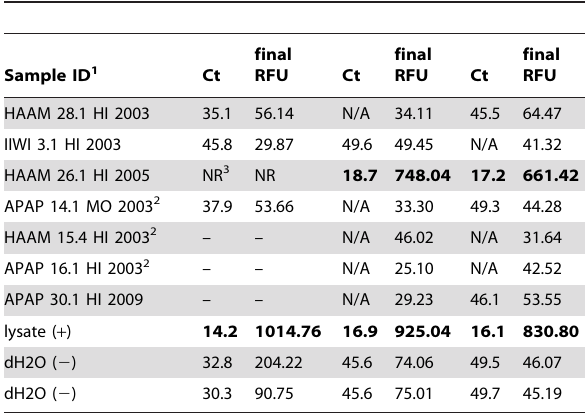
Successful amplifications (Ct , 25 and final RFU . 425) are indicated in bold . All values are based on PCR Base Line Subtracted Curve Fit Data as calculated using iCycler version 3.1 software (BioRad). The threshold intensity was 37.0 rfu for the first reaction, 48.3 rfu for the second reaction, and 10.8 rfu for the third reaction. 1 A dash ( 2 ) indicates a failed first reaction and potential false negative, N/A indicates that no Ct value was assigned because the signal for the sample never reached the threshold intensity for that reaction. 2 Variant numbers correspond to Avipoxvirus clusters 1 and 2 as previously described [8]; NS indicates not sequenced.